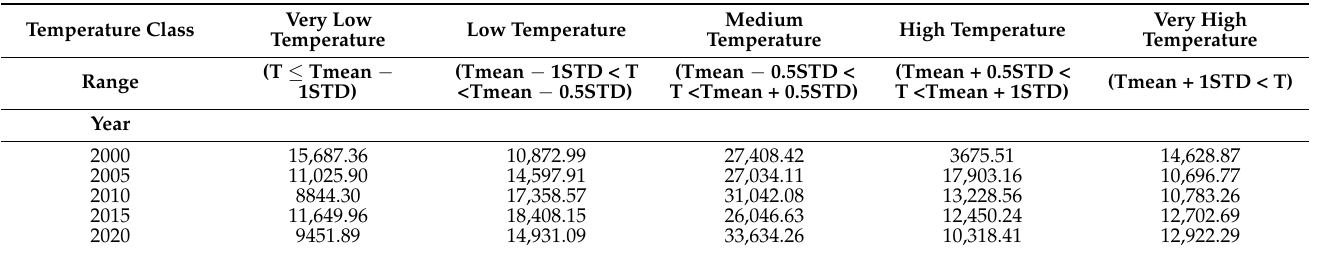
Figure 5. NLST classification map in 2000, 2005, 2010, 2015, and 2020. Table 5. Area covered by each NLST class (km 2 ).